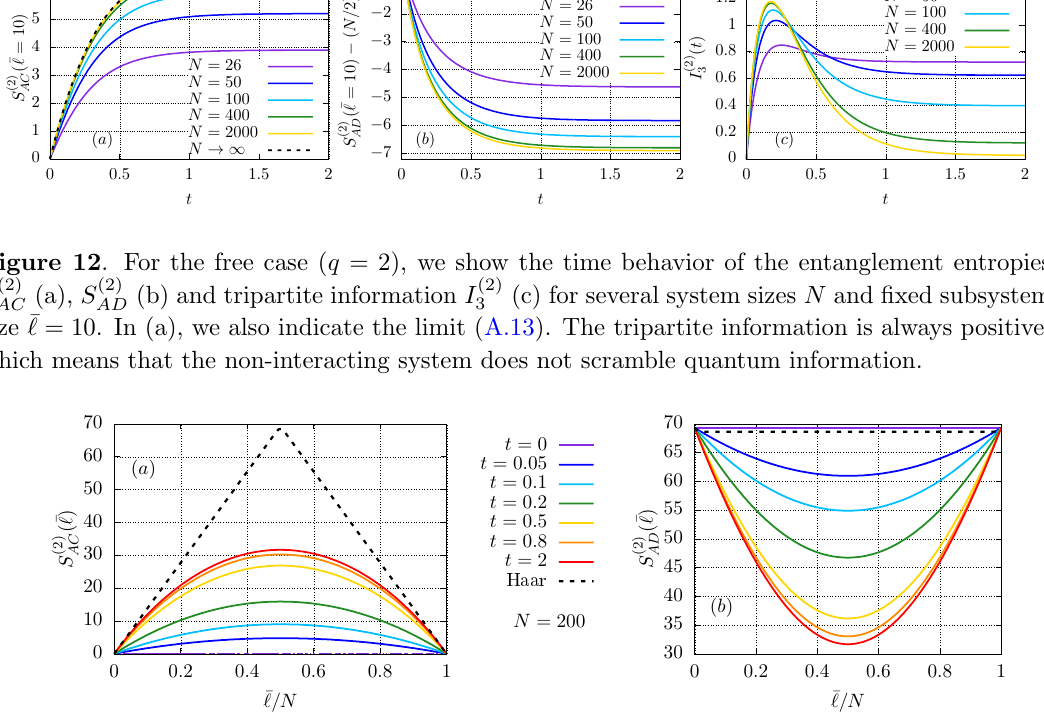
(a) and S (2) (b) for various subsystem sizes (cid:22) ‘ and AC AD